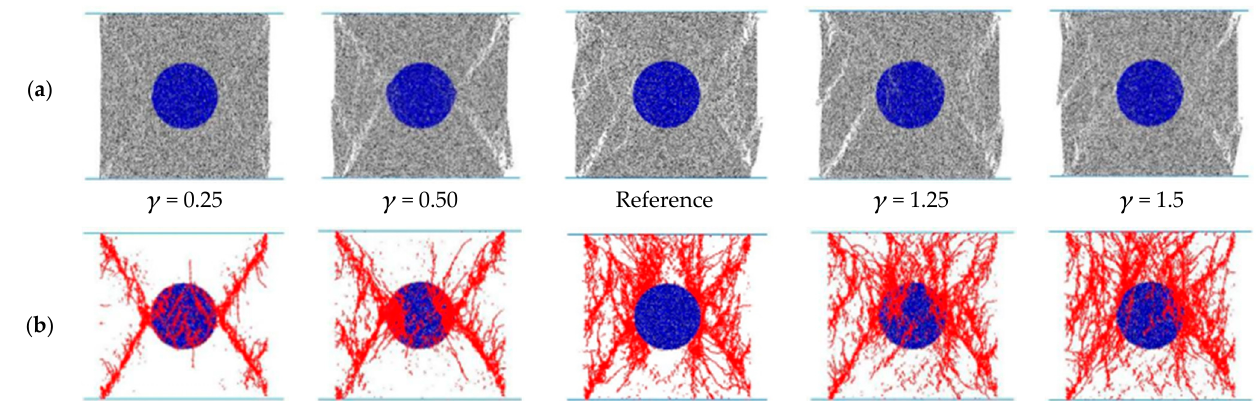
Figure 11. Typical failure modes of specimens in Group 4: ( a ) failure mode of specimen; ( b ) failure mode of concretion.